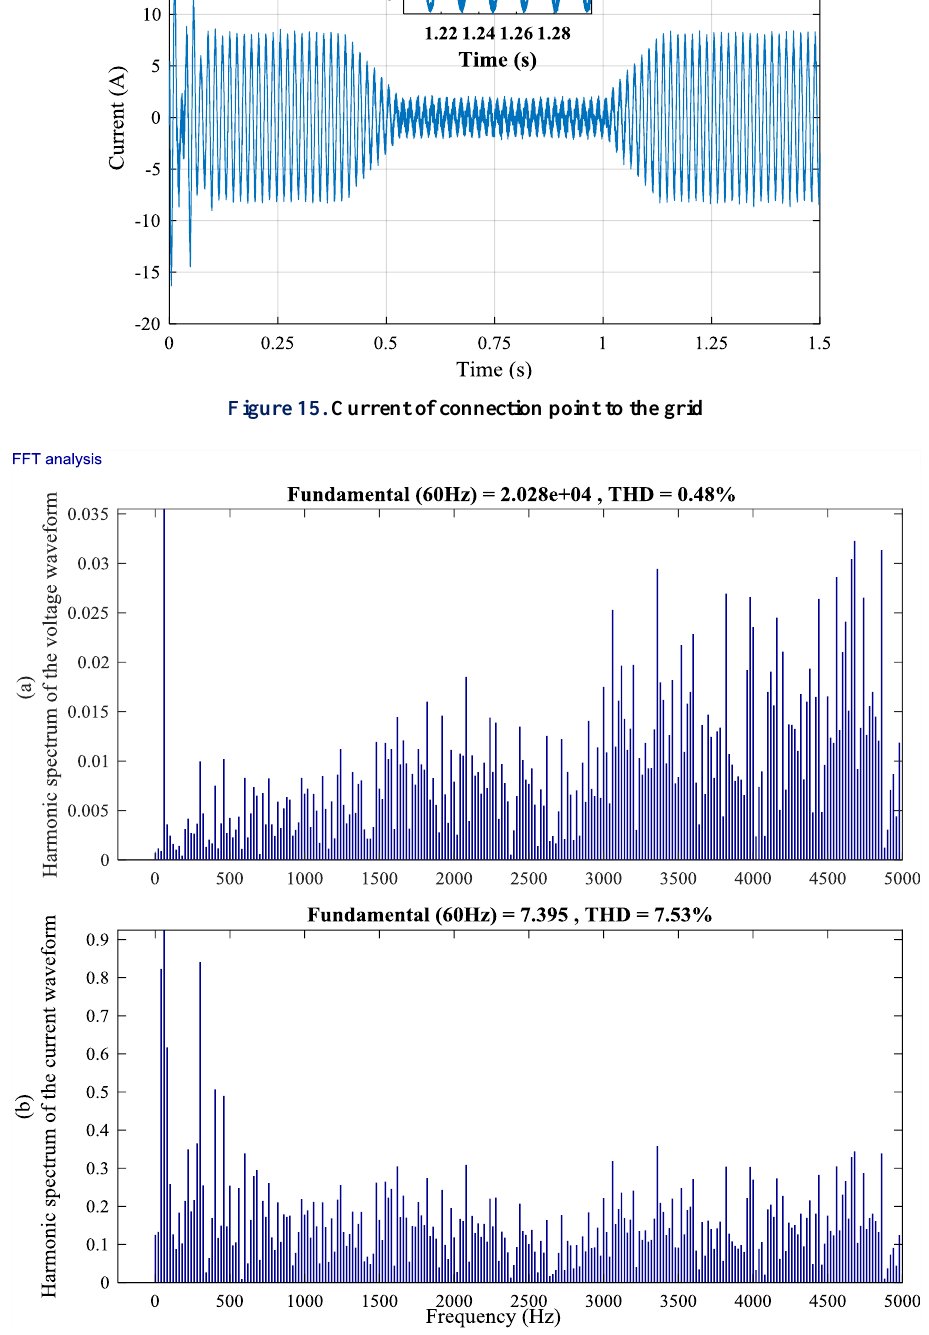
Figure 16. The Total Harmonic Distortion (THD) of output